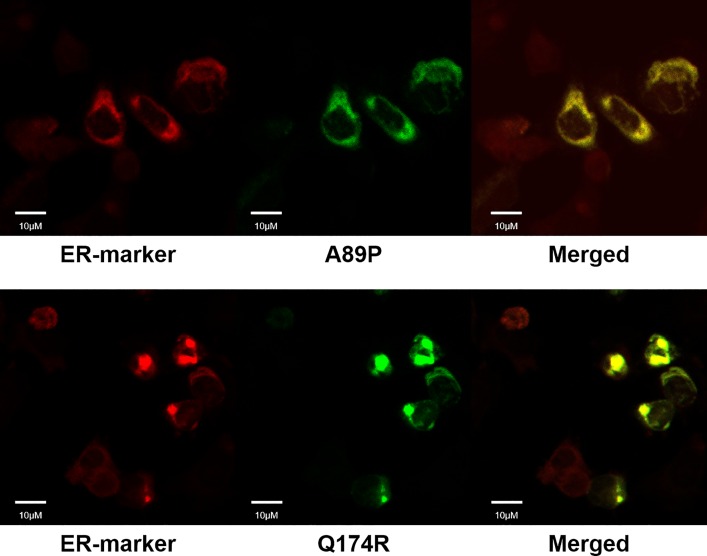
Localization of A89P/Q174R mutant within the ER.Using the ER specific marker Anti-calreticulin antibody conjugated with Alexa Fluor® 488, the A89P and Q174R AVPR2 mutants were determined to be resided within the ER. Scale bar, 10μM.